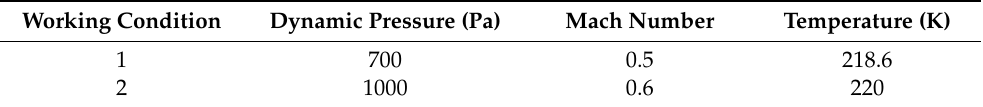
Table 2. Working